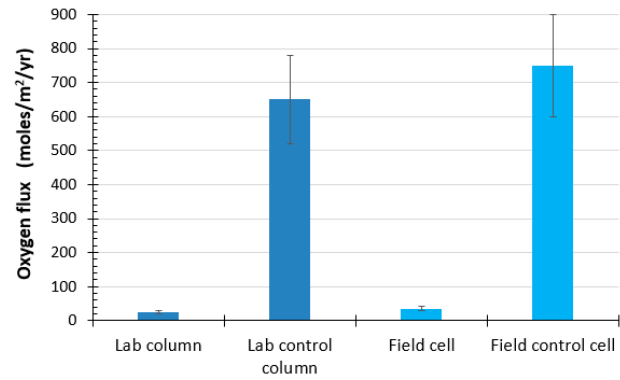
Figure 10. Oxygen fluxes passing through the surface of the MRL.